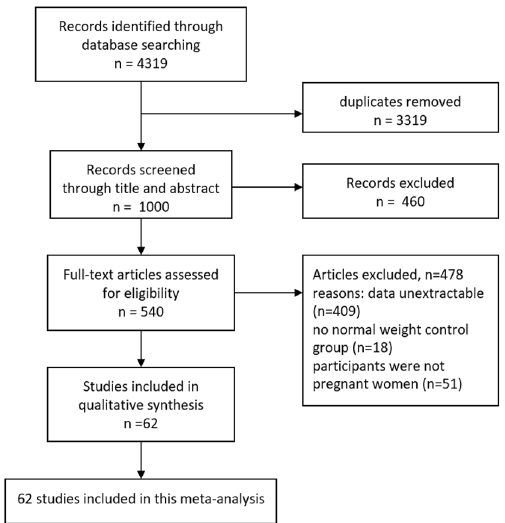
Figure 1. Flow diagram of the study selection